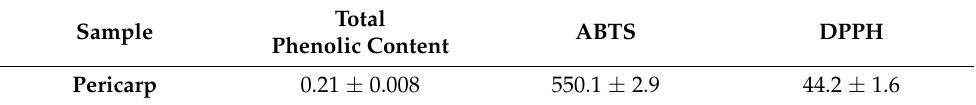
Table 2. Antioxidant activity of pericarp (total phenolic content, ABTS and DPPH). Sample